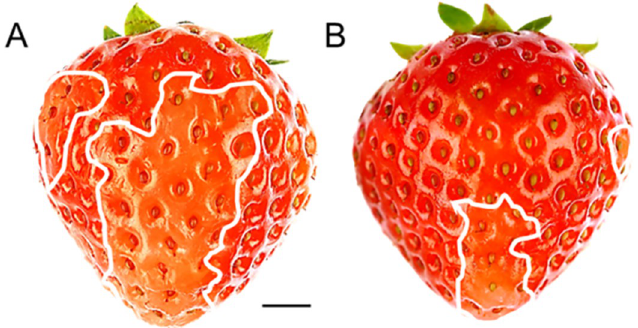
Fig 1. Typical symptoms of water soaking in strawberry ‘Florentina’ after incubation in (A) water (score 3) and in (B) 10 mM of CaCl 2 (score 2) for 8 h. Water soaking was indexed using a five-point rating scale: score 0, no water soaking; score 1, < 10% of the surface area water-soaked; score 2, 10 to 35%; score 3, 35 to 60%; score 4 > 60%. The white line indicates the extent of the water-soaked area. Scale bar in A = 5 mm. The images are representative of 15 individual fruit replicates per